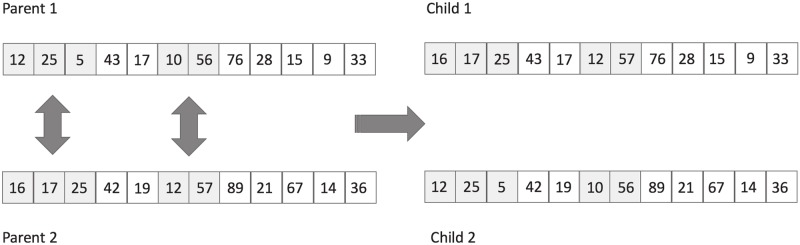
Crossover operator.